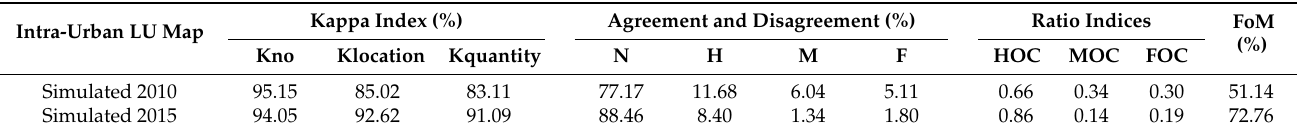
Table 4. Model validation results of observed and simulated 2010 and 2015 intra-urban-LU maps for Lusaka city, Zambia. Intra-Urban LU Map